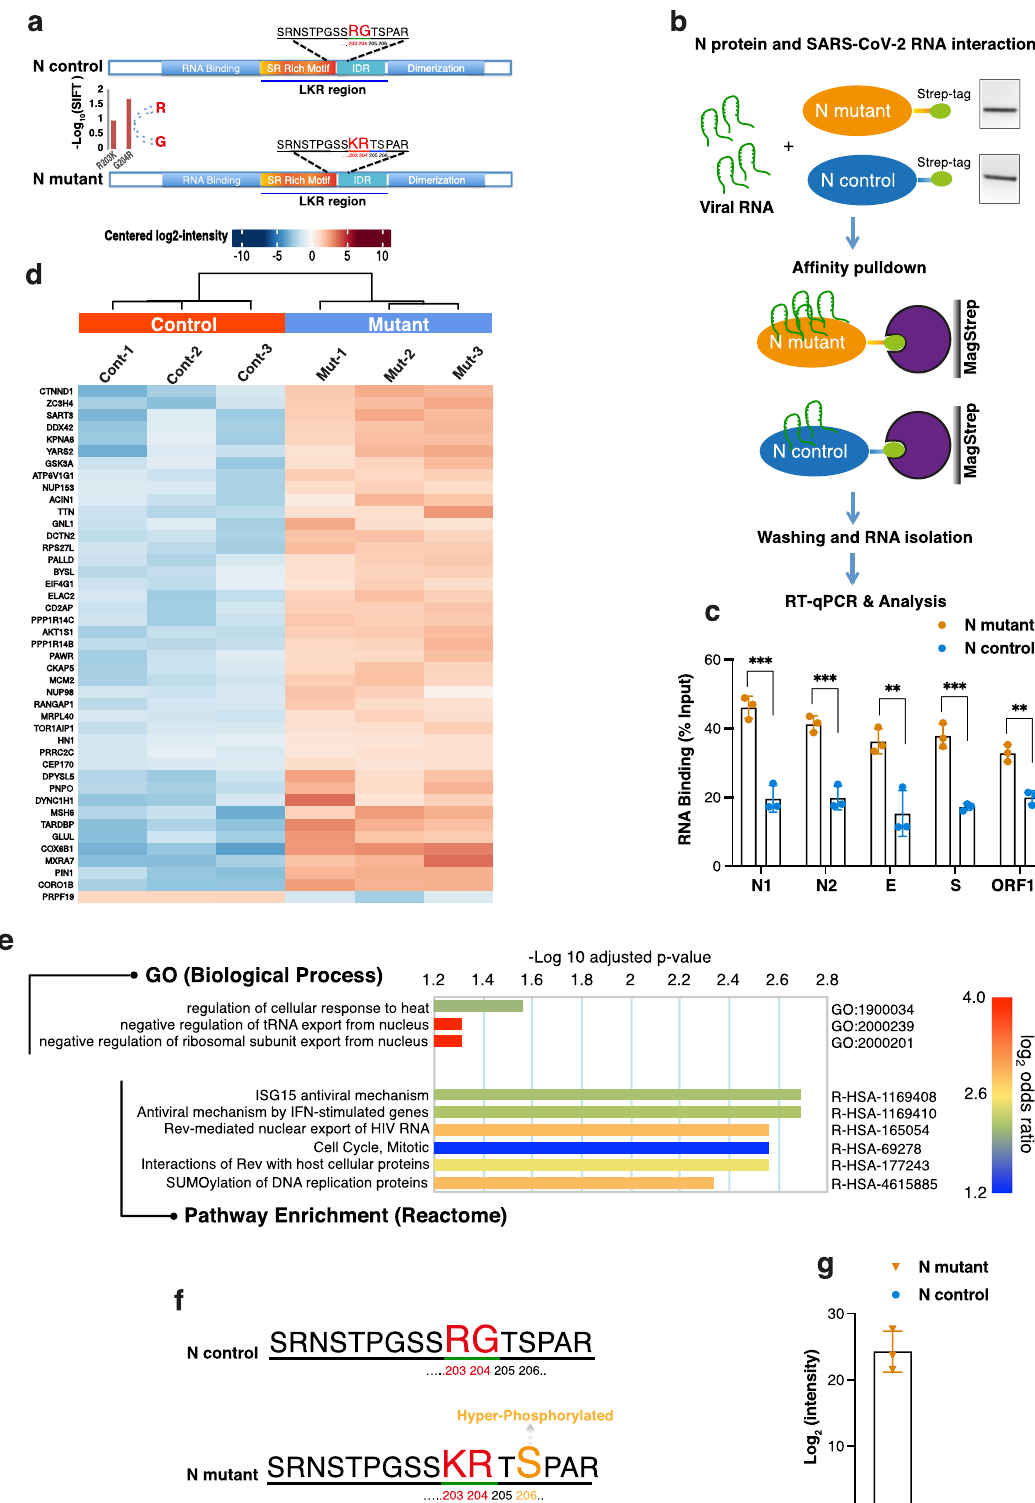
potential compared to the control N protein (without the changed amino acids) at low protein concentration (Supplementary Fig. S9). Given that the oligomerization of N protein acts as a platform for viral RNA interactions 36 , we sought to examine the binding af fi nity of mutant and control N protein with viral RNA